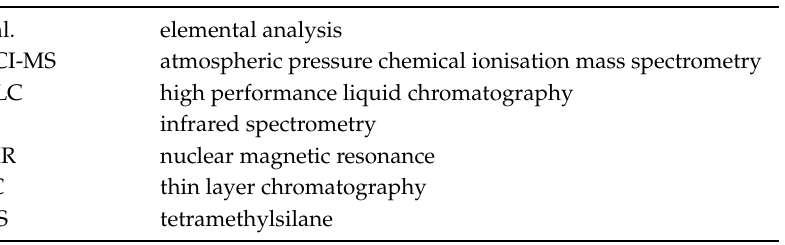
Supplementary Materials: The following are available, Figure S1: 1 H-NMR spectrum of 3 , Figure S2: 13 C-NMR spectrum of 3